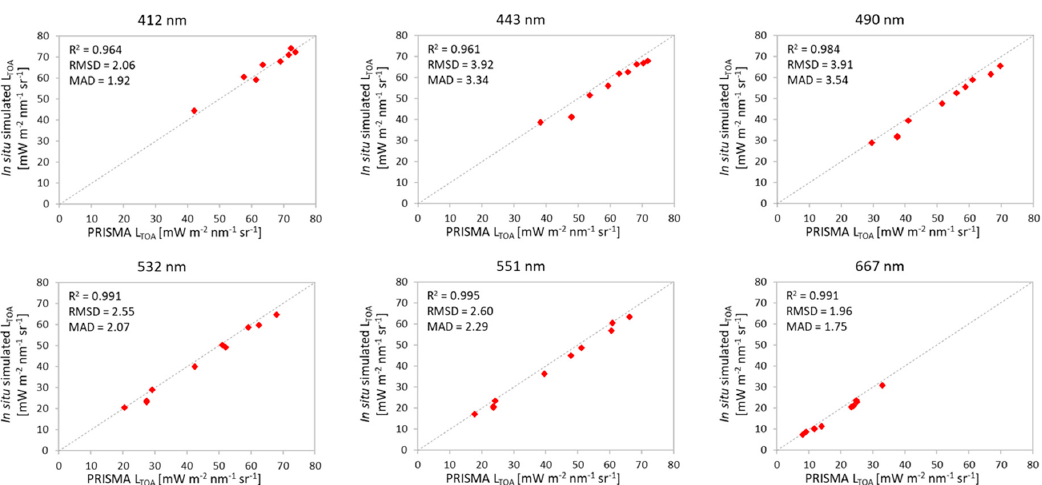
Figure 4. Scatterplots of TOA radiances from PRISMA (x-axis) vs. 6SV simulations from in situ data (y-axis) and PRISMA (x-axis) for the nine test sites. The plots are generated for wavelengths (in nm) of the six bands which are common to all in situ data.